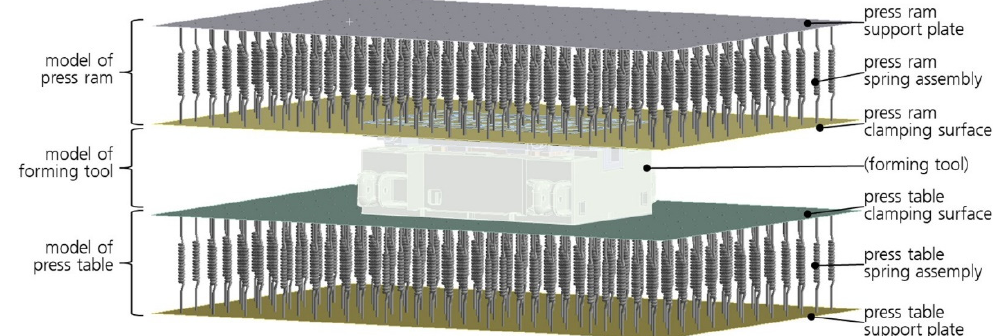
Figure 3. Geometry of generic substitute models to represent the elastic behavior of the clamping surface at the ram (top) and the clamping surface at the table (bottom), consisting of elastic plates and discrete spring stiffnesses.